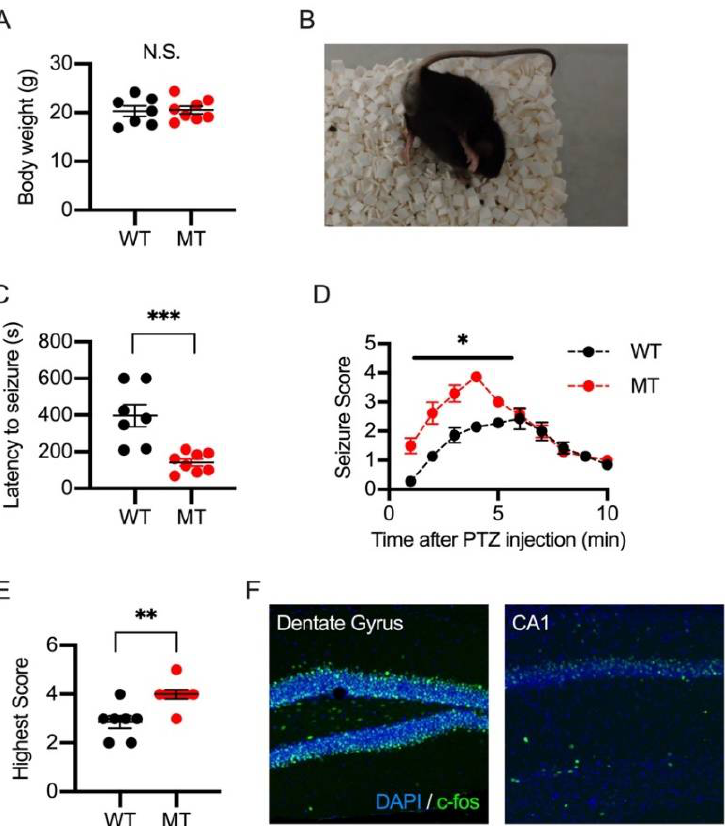
Figure 6. PTZ-induced seizures in wild-type and SIK1 mutant mice. ( A ) Body weight of the 6-week- old wild-type and SIK1-MT mice. Body weight of 6-week-old mice was unchanged. ( B ) Representa- tive photo image of mouse posture during PTZ-induced spasms. See also Supplementary Movie